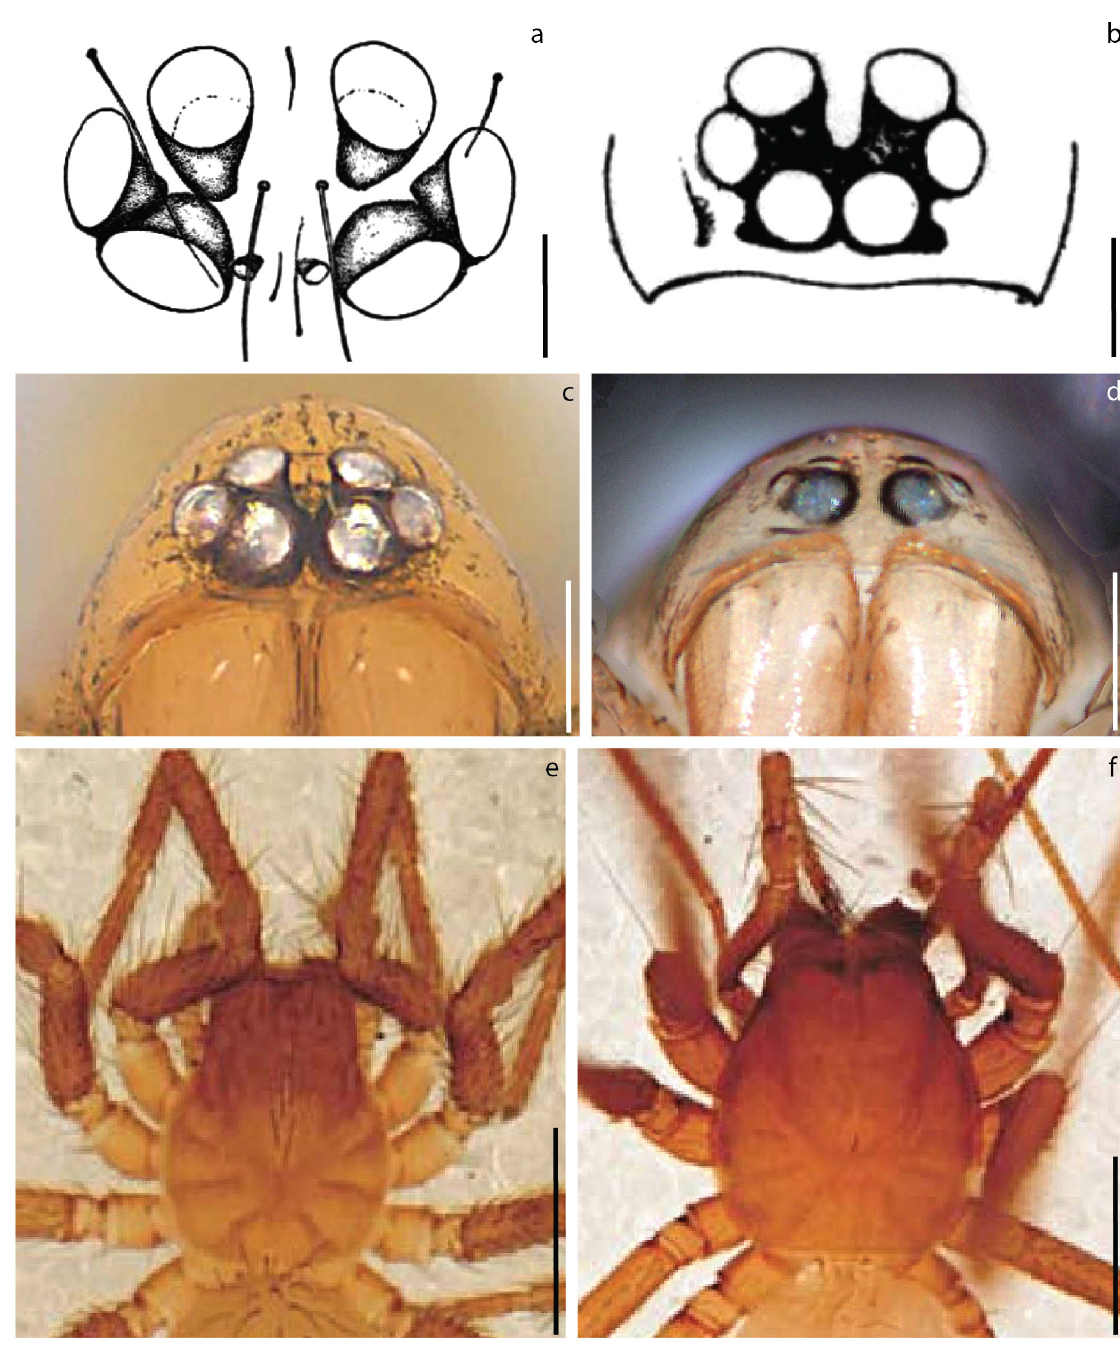
Fig. 7. Examples of eye reduction in the Hahniidae Bertkau, 1878. a . Eight eyes with minute AME, Alistra myops (Simon, 1898); modified from Schiapelli & Gerschman de P. 1959. b–d . Six eyes. b . Amaloxenops vianai Schiapelli & Gerschman, 1958; modified from Schiapelli & Gerschman de P. 1958. c . Scotospilus longus Zhang, Li & Pham, 2013; modified from Zhang et al. 2013. d . Hexamatia seekhaow gen. et sp. nov. e–f . No eyes, Iberina mazarredoi Simon, 1881; modified from Fernández- Pérez et al. 2014. Scale bars: a–d = 0.1 mm; e–f = 0.5